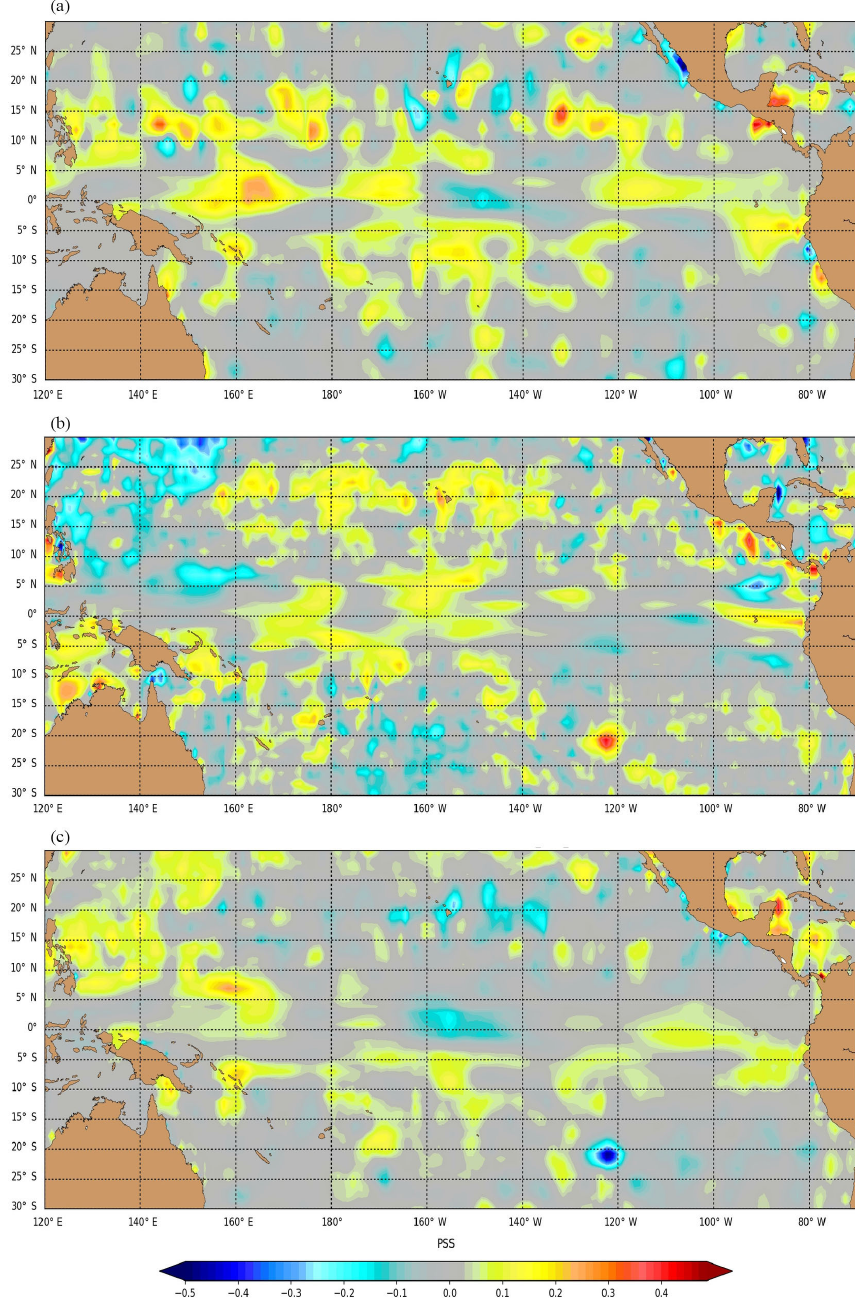
Figure 3. Example of model salinity bias ( x ) near the surface (Eq. 1) calculated from in situ data between 0 and 10m depth only (a) , of SSS bias ( ξ ) (Eq. 2) calculated from SMOS SSS (b) and salinity bias ( x ) (Eq. 2) from in situ data between 0 and 10m and SMOS SSS (c) in the tropical Pacific (week of 20–27 January